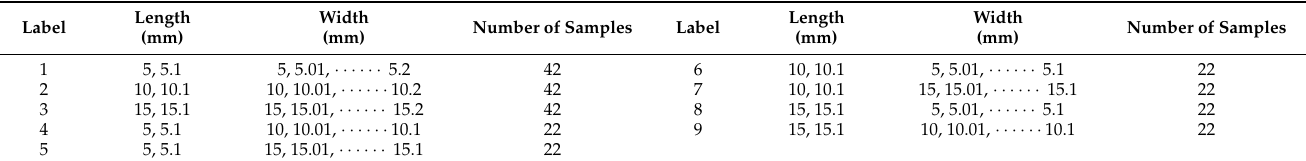
Table 3. The variation of length and width of delamination between top layer and the adjacent second layer